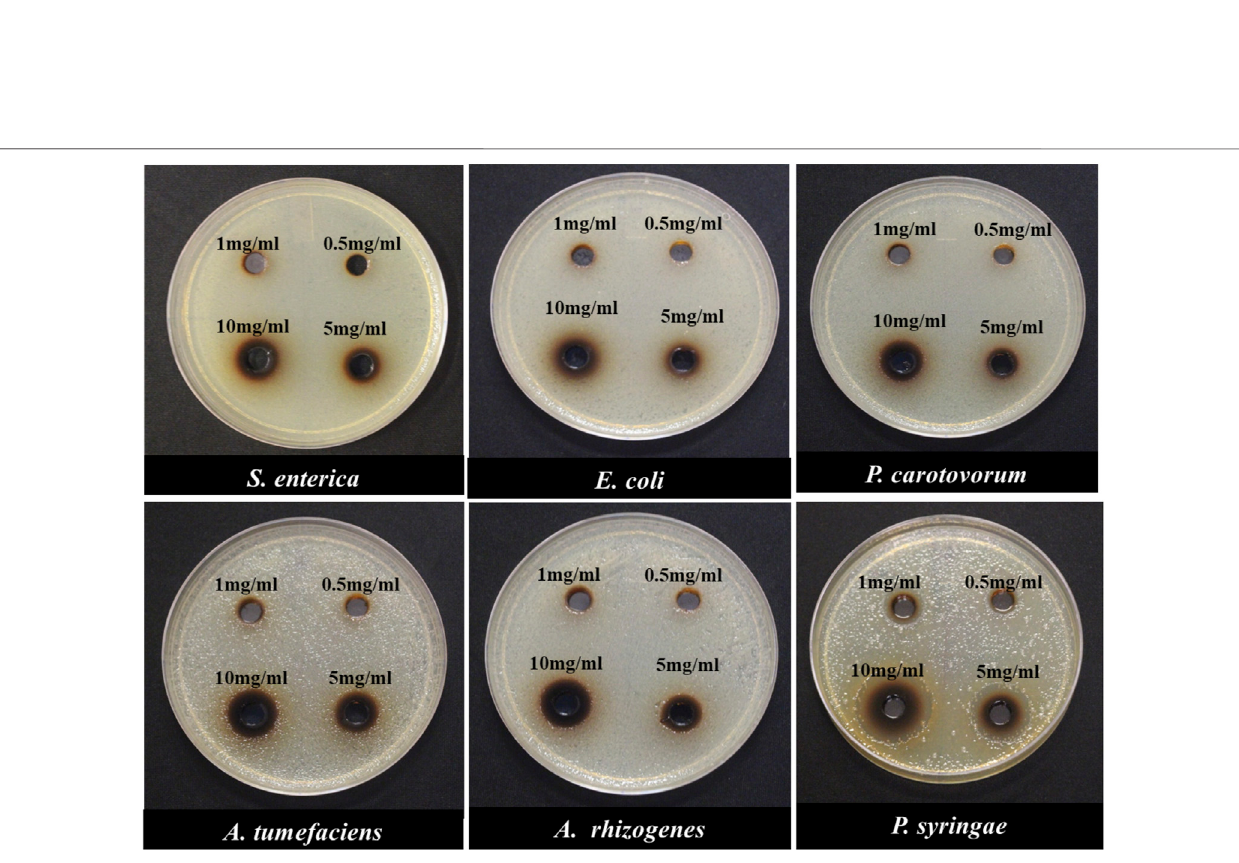
Frontiers in Nanotechnology |